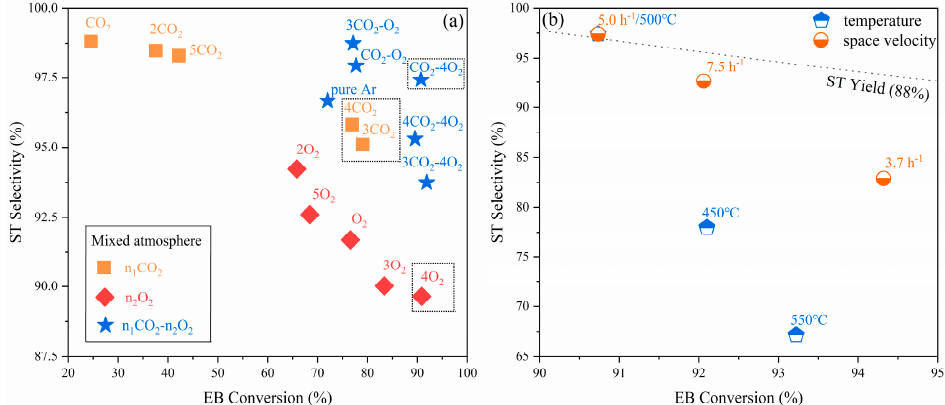
Figure 8. EB-ODH performance ( a ) in various atmospheres, with the following experimental condi- tions: reaction temperature 500 °C, T EB = 25 °C, reaction time 5 h, fl ow rate 25 mL/min, atmosphere CO 2 /Ar, O 2 /Ar, CO 2 -O 2 /Ar, catalyst dosage 1000 mg, space velocity = 5.0 h − 1 ; ( b ) under di ff erent tem- perature and space velocities, di ff erent temperature experimental conditions: T EB = 25 °C, reaction time 5 h, fl ow rate 25 mL/min, atmosphere 1CO 2 -4O 2 , catalyst dosage 1000 mg, space velocity = 5.0 h − 1 ; space velocities experimental conditions: reaction temperature 500°C, T EB = 25 °C, reaction time 5 h, fl ow rate 25 mL/min, atmosphere 1CO 2 -4O 2 . The CO 2 excess coe ffi cients (n) represent the mul- tiplication of the increase in the molar amount of CO 2 compared to the thermoneutral conditions in Table 1. The O 2 excess coe ffi cients (n) and the excess coe ffi cients (n) for a mixed CO 2 -O 2 atmosphere are de fi ned similarly to the CO 2 excess coe ffi cients.